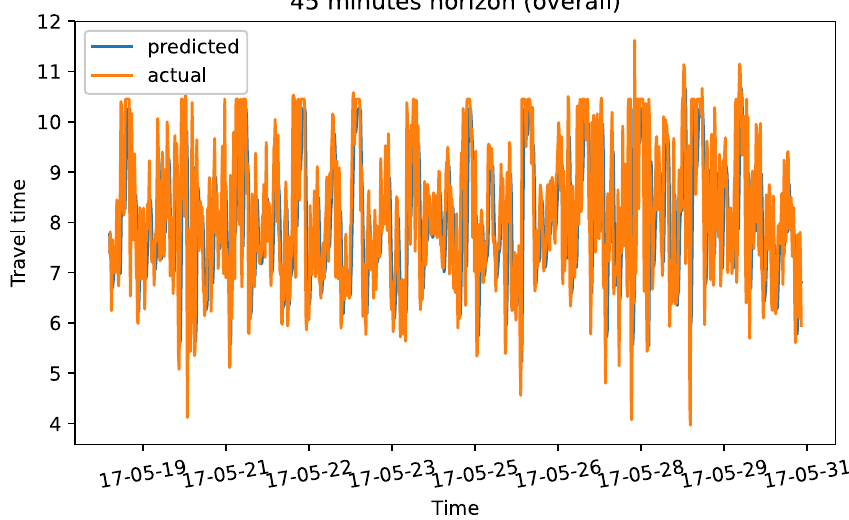
Fig 10. Prediction results for 45 minutes horizon on test data